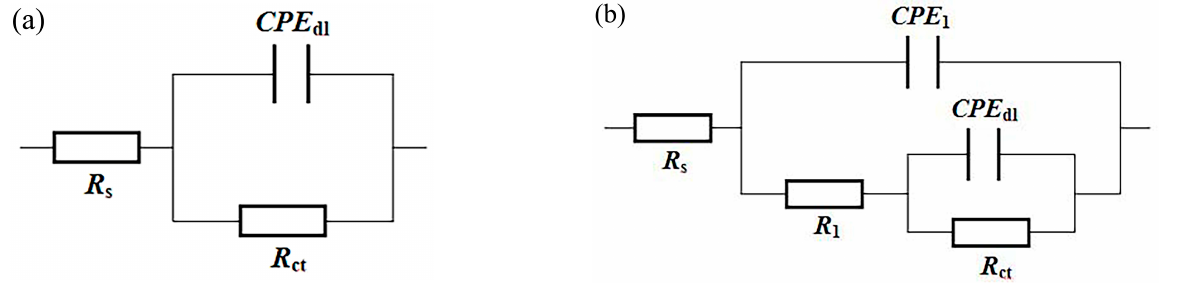
Figure 9. Electrochemical equivalent circuits used for fitting the EIS data: ( a ) NdFeB substrate, ZC and ZFC; ( b ) PZC and PZFC.